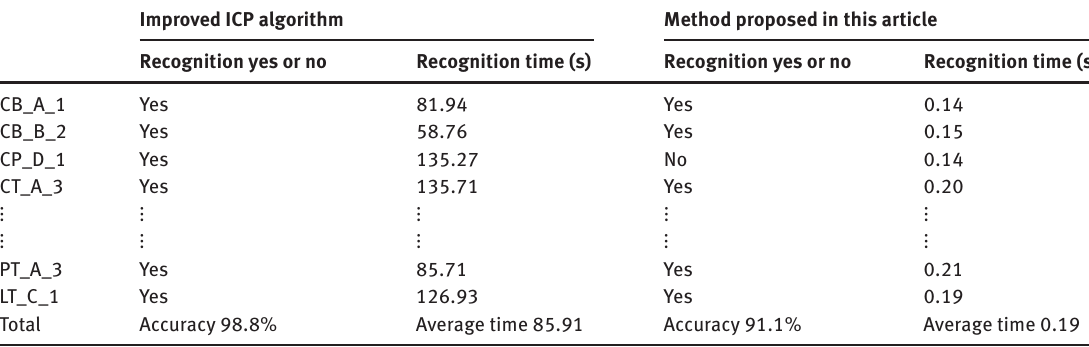
Table 5: Comparison of Two Methods on Recognition Effect. Improved ICP